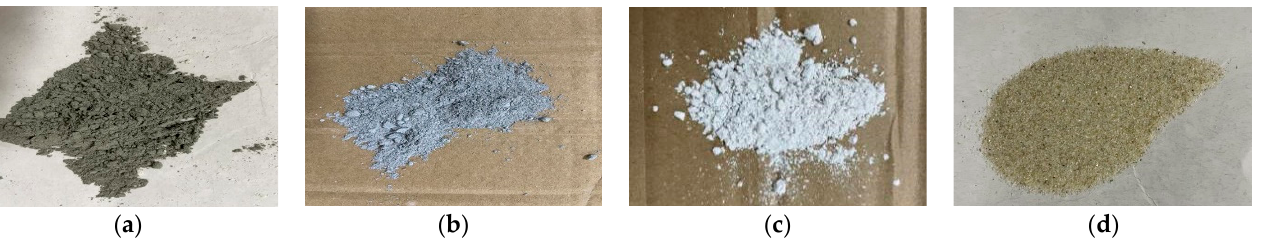
Figure 1. ( a ) FA, ( b ) SF, ( c ) GGBS, and ( d ) quartz sand used in specimens of this experiment. Table 2. Main properties of the PVA